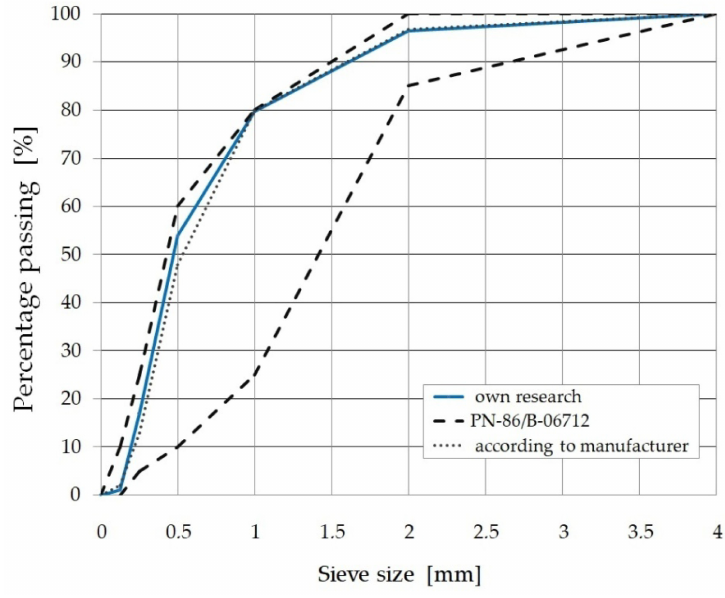
Figure 1. Grading curve of the aggregate used in the research program.